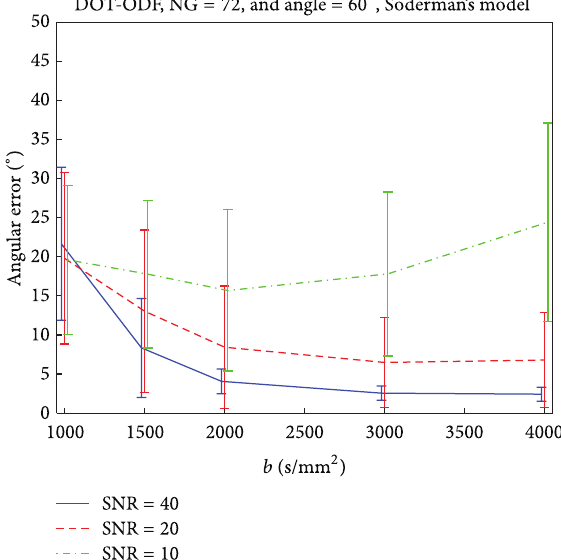
Figure 9: Influence of the 𝑏 -value on the accuracy of the analytical DOT-ODF imaging for angle of 60 ∘ .